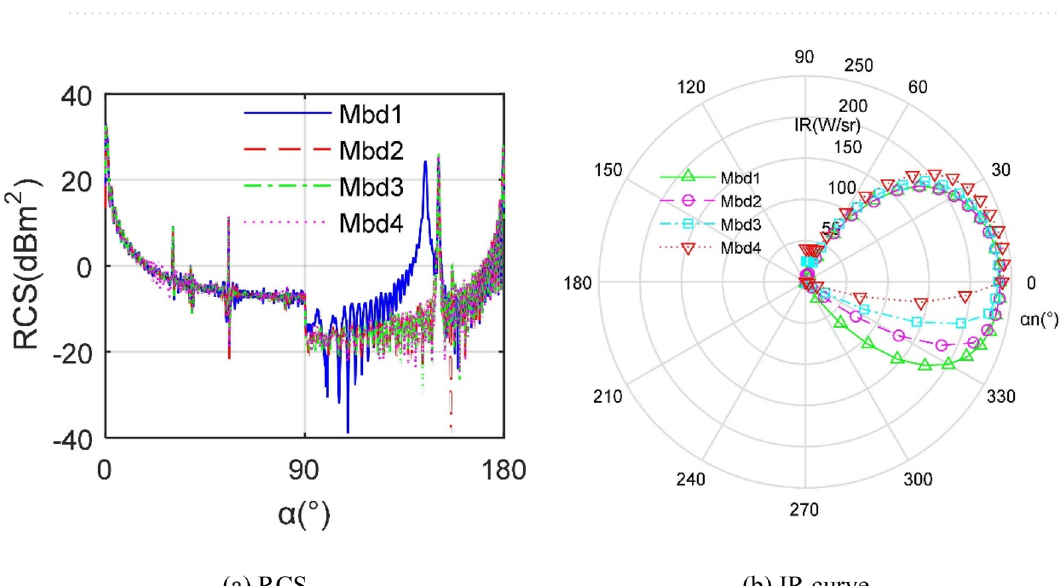
Figure 12. Comparison of stealth characteristics of aircraft under different M bd models.